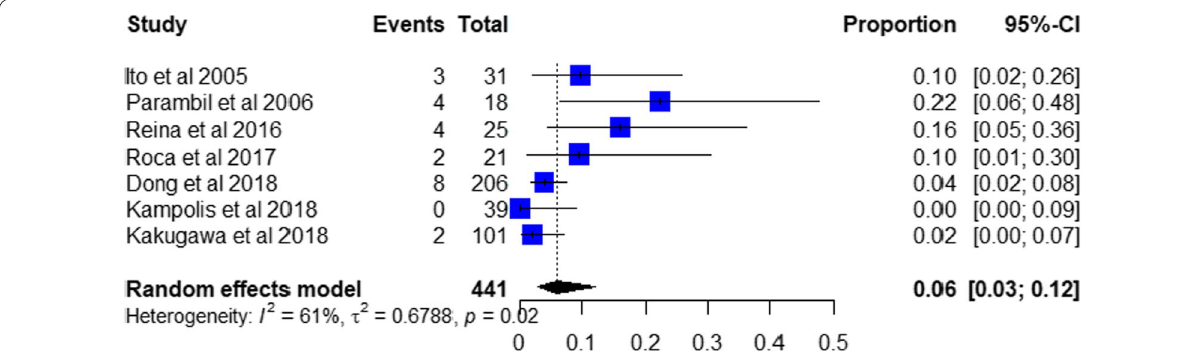
Fig. 8 Meta‑analysis of the Organizing pneumonia in patients with Sjogren’s syndrome